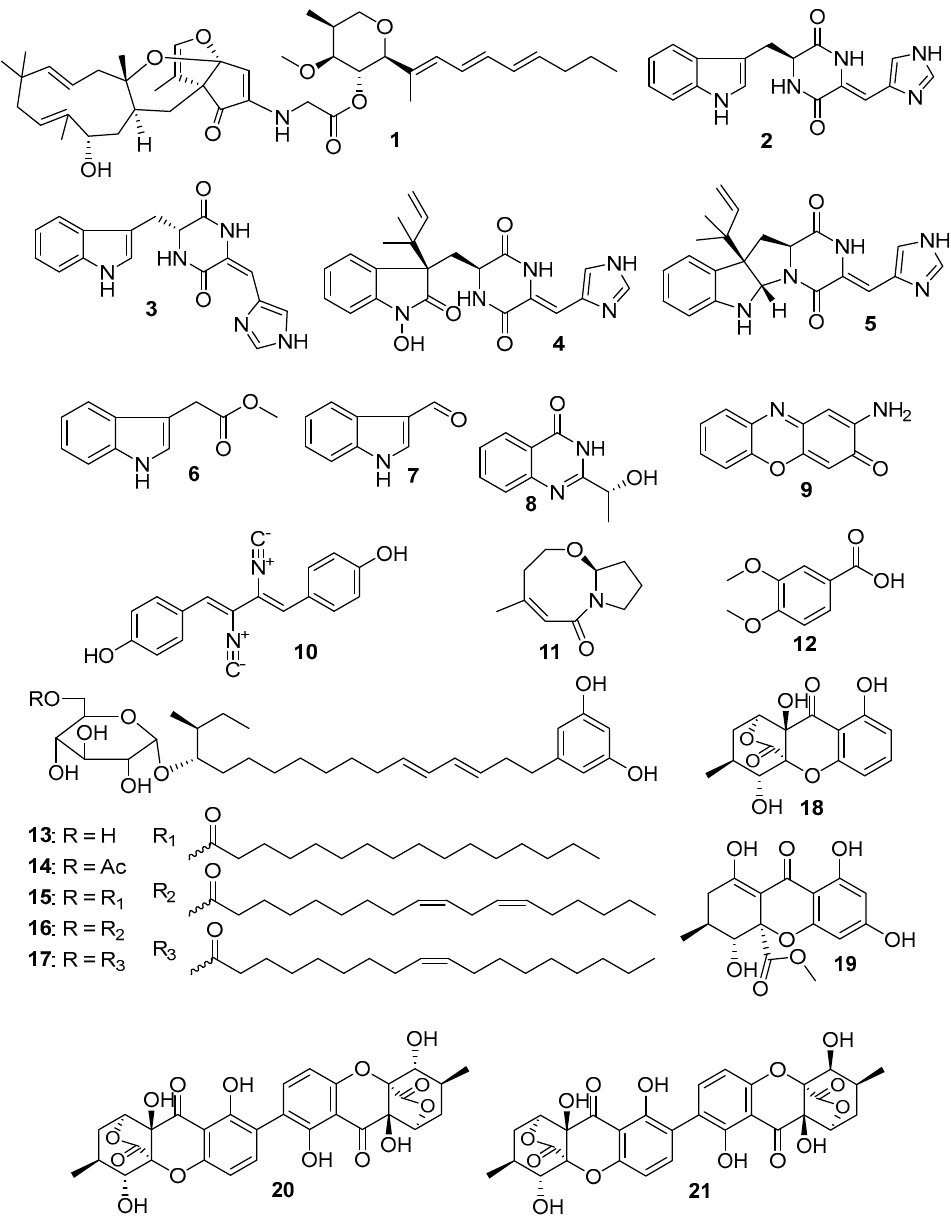
Figure 1. Chemical structures of compounds 1 – 21 from the marine fungus Penicillium sp. ZZ1750.